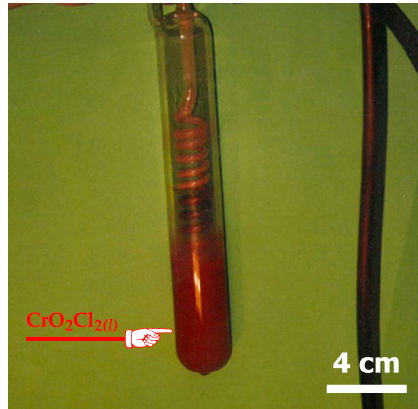
Figure 18. Visual image of the CrO 2 Cl 2(l) generated during the thermal treatment of chromite by Cl 2 + air and collected in liquid state at –35 °C.